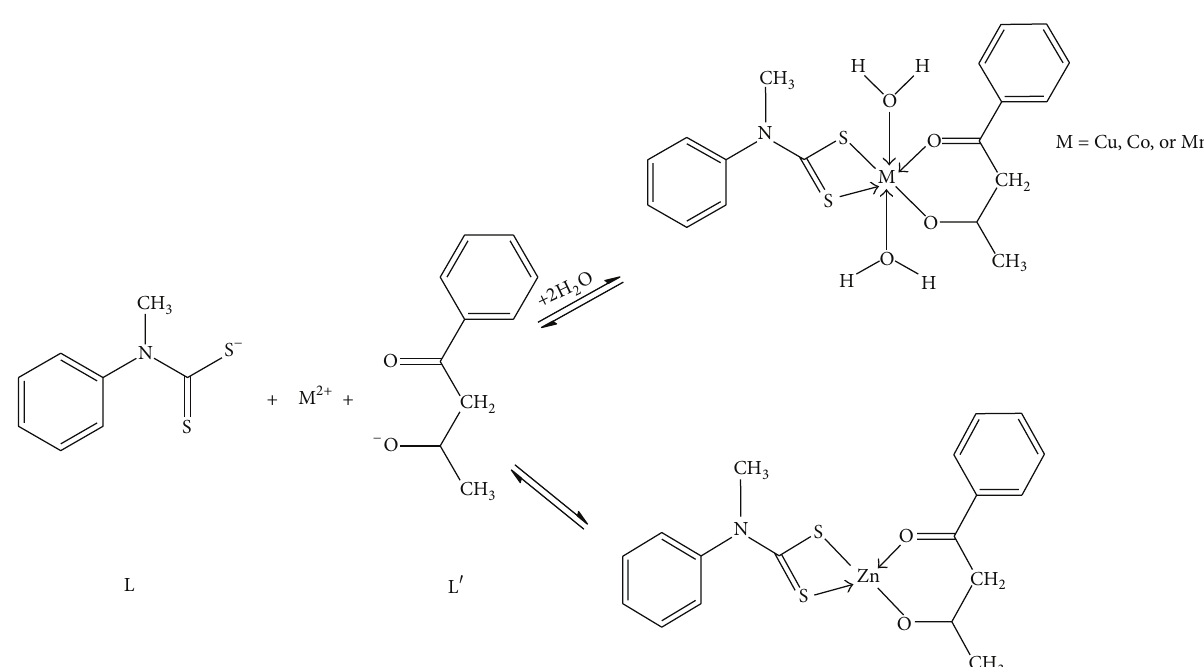
Figure 3: Schematic presentation of the synthesis of the